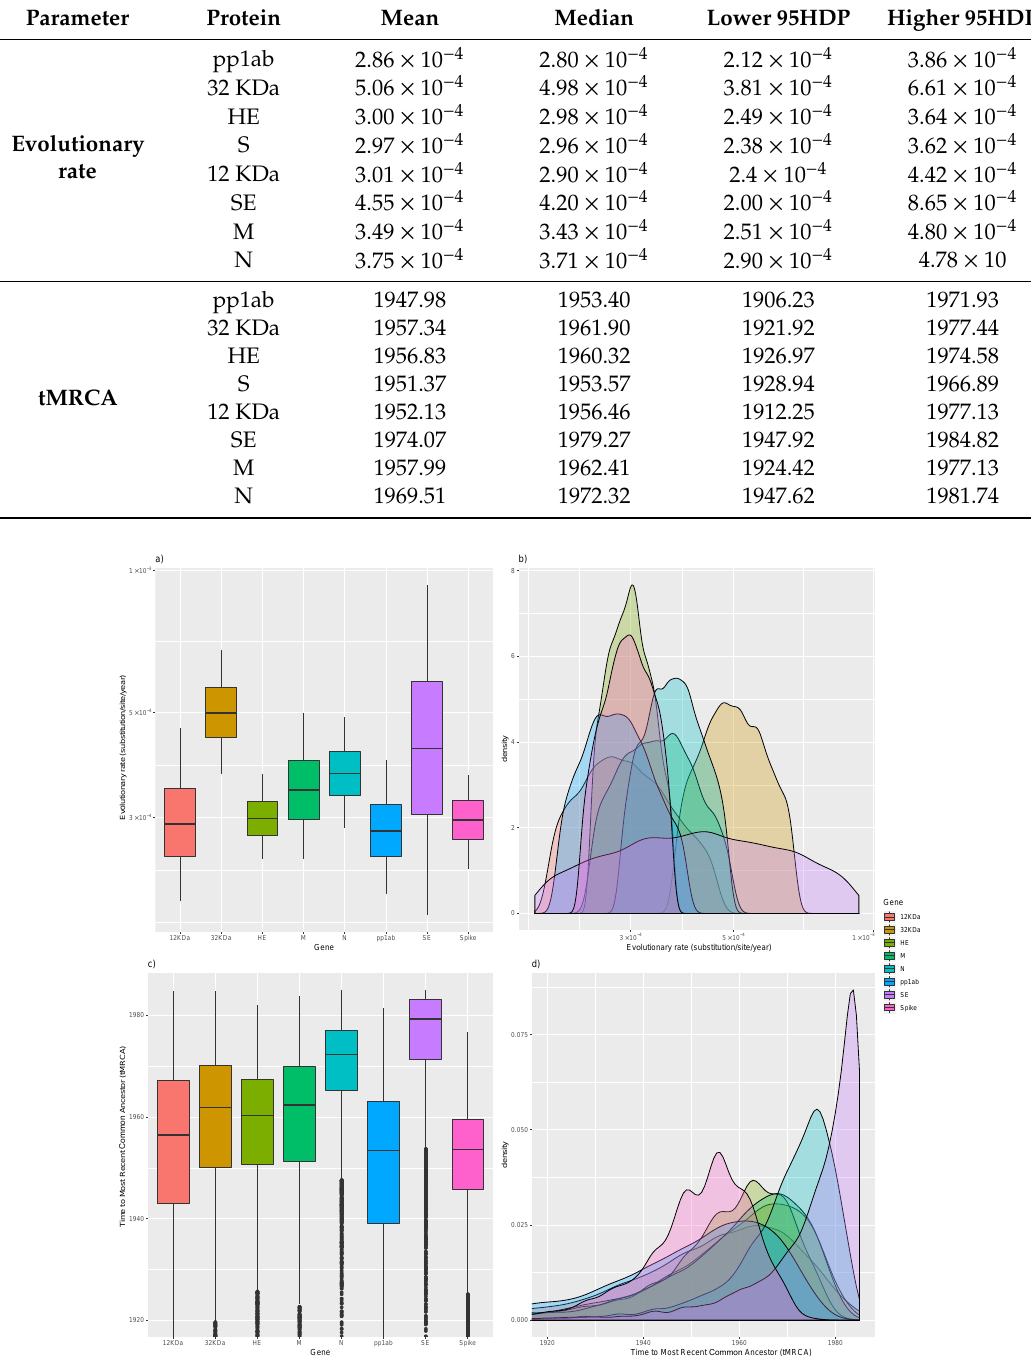
Figure 2. Upper figure: Boxplot ( a ) and density plot ( b ) of the evolutionary rate posterior probability. Lower figure: Boxplot ( c ) and density plot ( d ) of time to most recent common ancestor (tMRCA) posterior probability. Results are reported for all considered genes. The 95% high posterior density (95HPD) intervals are reported for both figures. The median values are displayed as a bold line in the